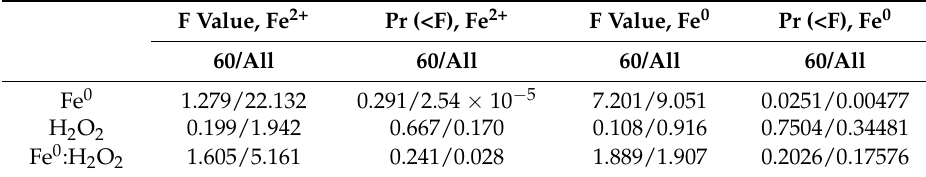
Table 7. ANOVA results for COD and Fe 2+ /Fe 0 , time 60 (min) vs. all process times. F Value, Fe 2+ Pr (<F), Fe 2+ F Value, Fe 0 Pr (<F), Fe 0